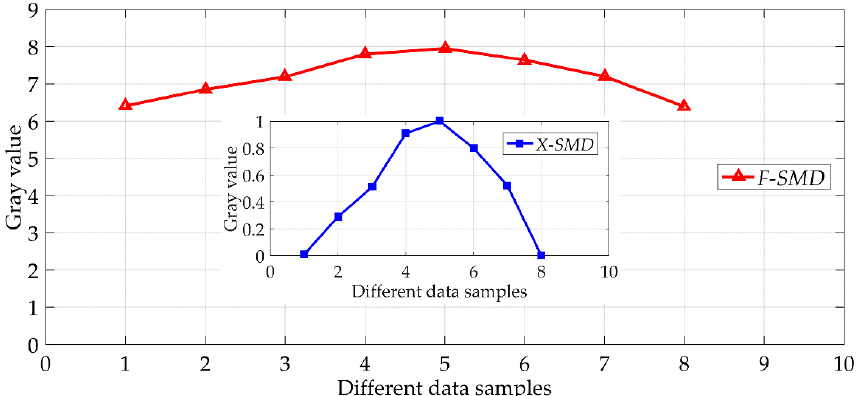
Figure 10. Gray value change trend.